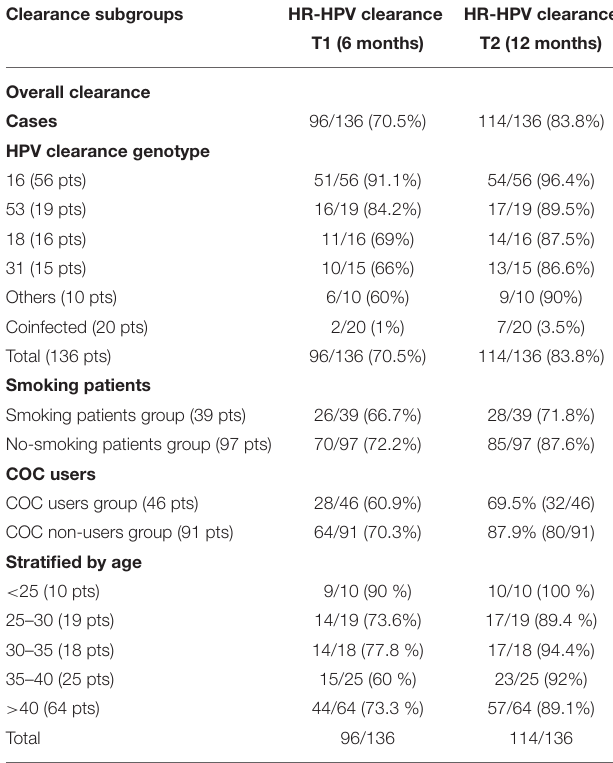
TABLE 1 | Patients characteristics, histological characteristics and post-operative